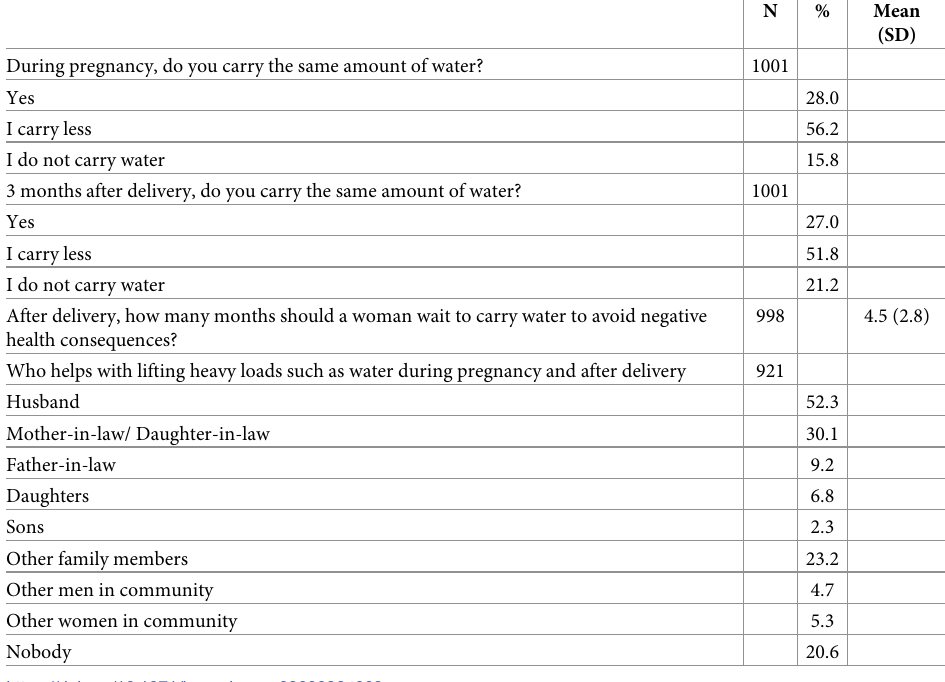
Table 3. Water carrying during pregnancy and after